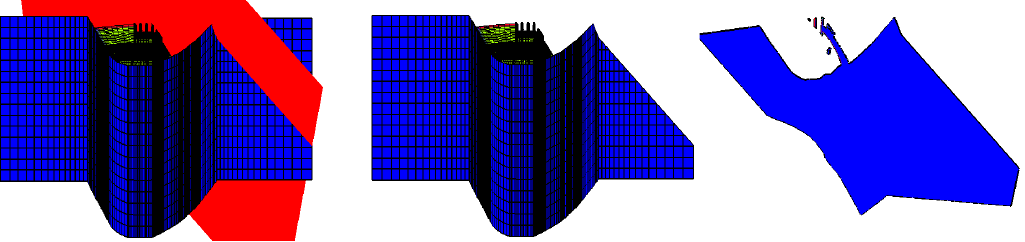
Figure 7. Traditional plane cutting result of dam II.